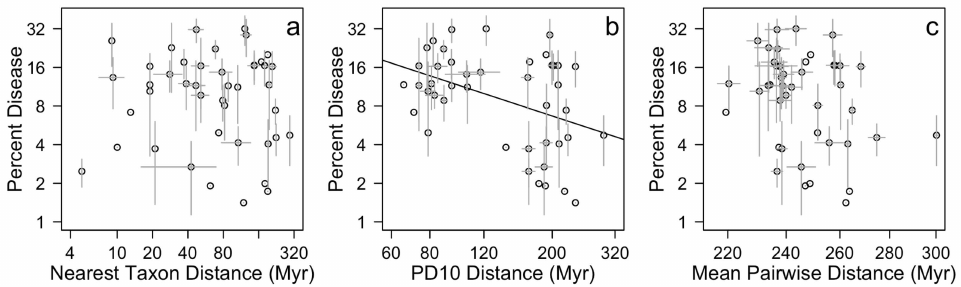
Figure 6. Phylogenetic isolation as a predictor of plant disease severity: comparison of three phylo- genetic distance metrics. Disease severity on the meadow species in Figure 1, as a function of three phylogenetic distance metrics for focal plants to their surrounding community. The PD10 metric ( b ) was a better predictor than either NTD ( a ) or meanPD ( c ). Panel b for PD10 is adapted from Figure2b in Parker et al. [25] and we have added the equivalent panels for NTD and meanPD based on the same data. The regression analysis for PD10 showed a highly significant effect of phylogenetic isolation on reducing disease severity (log 10 (mean % Disease) = 2.638 − 0.788 × log 10 (phylogenetic distance); R 2 = 0.171, p = 0.006), but such a pattern was not revealed when using either NTD (R 2 = 0.001, p = 0.82) or meanPD (R 2 = 0.081, p = 0.065) as measures of phylogenetic distance. Each circle repre- sents the mean % foliar disease and mean phylogenetic metric for a species of plant across 10 replicate plots in the meadow; whiskers indicate standard error of the mean. Disease severity data previously published in